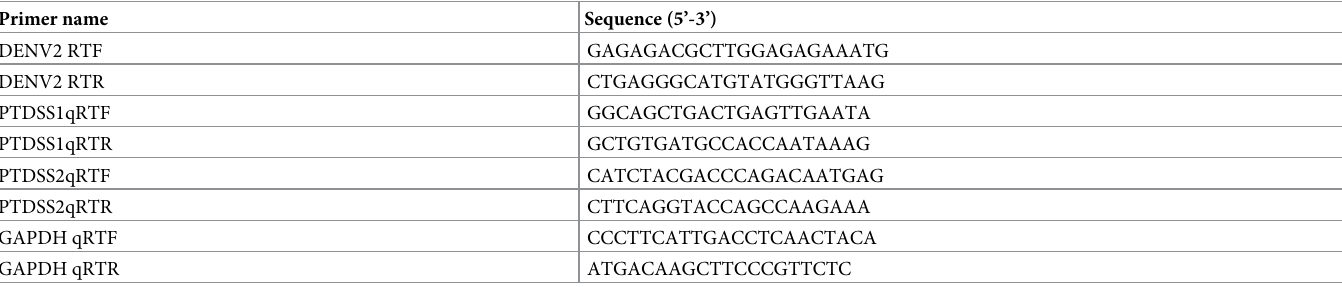
Table 1. Primer sequences used in this